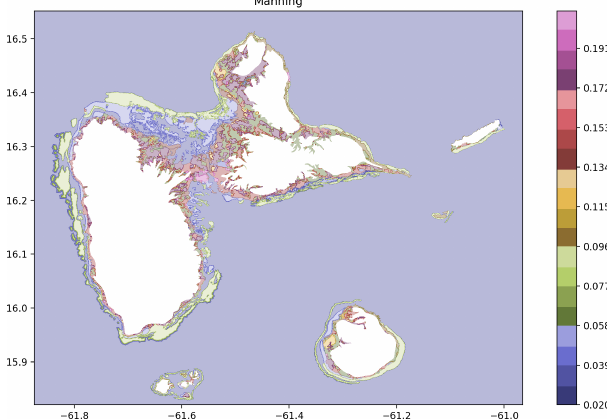
Figure 7. Values of Manning coefficient as a function of land use in